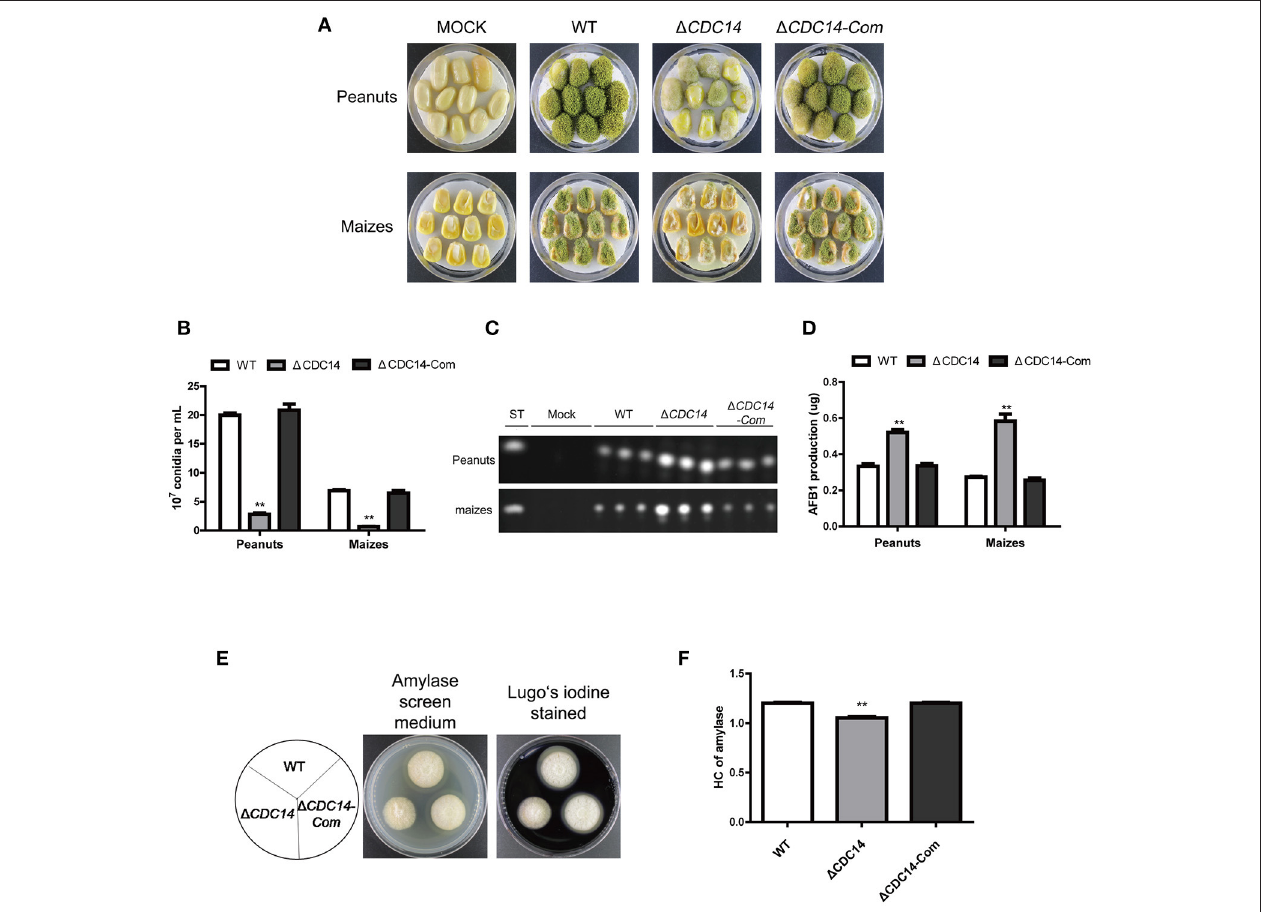
FIGURE 8 | 1 CDC14 mutant was impaired in the infection of plant seeds. (A) Peanut and maize seeds were inoculated with WT, 1 CDC14 and 1 CDC14- Com strains and cultured at 29 ◦ C for 6 days. (B) Quantification analysis of conidia from the infected peanut and maize seeds. (C) TLC was used to detect the AFB1 production extracted from the infected peanut and maize seeds. (D) Quantification of AFB1 production as in (C) . (E) Assay of lipase activity in different strains and the amylase screening medium was stained with Lugo’s iodine. (F) Quantification analysis of amylase’s HC according to the results of (E) . HC = the diameter of transparent zonel/the diameter of colonies (** p ≤